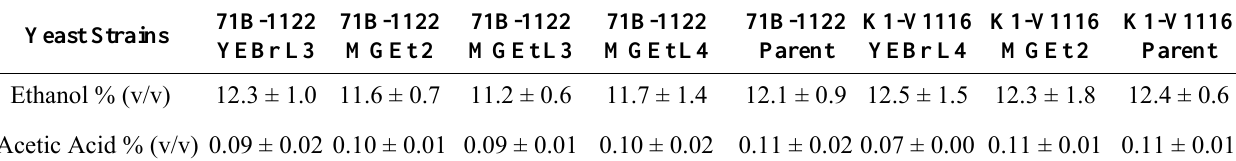
Table 1. Average concentrations of ethanol and acetic acid produced in batch fermentation.